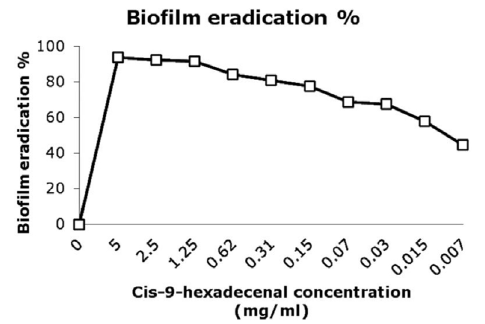
Fig. 3. Biofilm eradication percentage after treating the pre-formed biofilm with compound at various concentrations. The developed biofilms were treated with different concentrations of cis-9-hexedecenal for 24h or 1% DMSO as positive control. MTT assay was done to determine the percentage eradication of biofilm